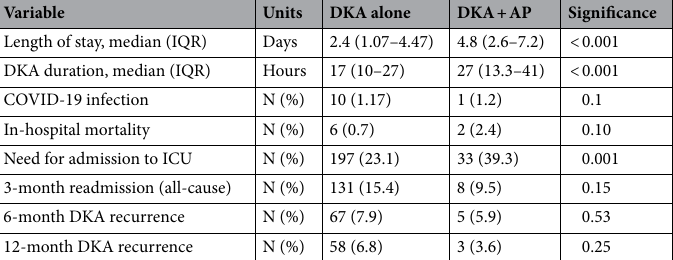
Table 3. Comparison of clinical outcomes between DKA vs DKA with AP patient groups. DKA Diabetic ketoacidosis, AP acute pancreatitis, IQR interquartile range, ICU intensive care unit.